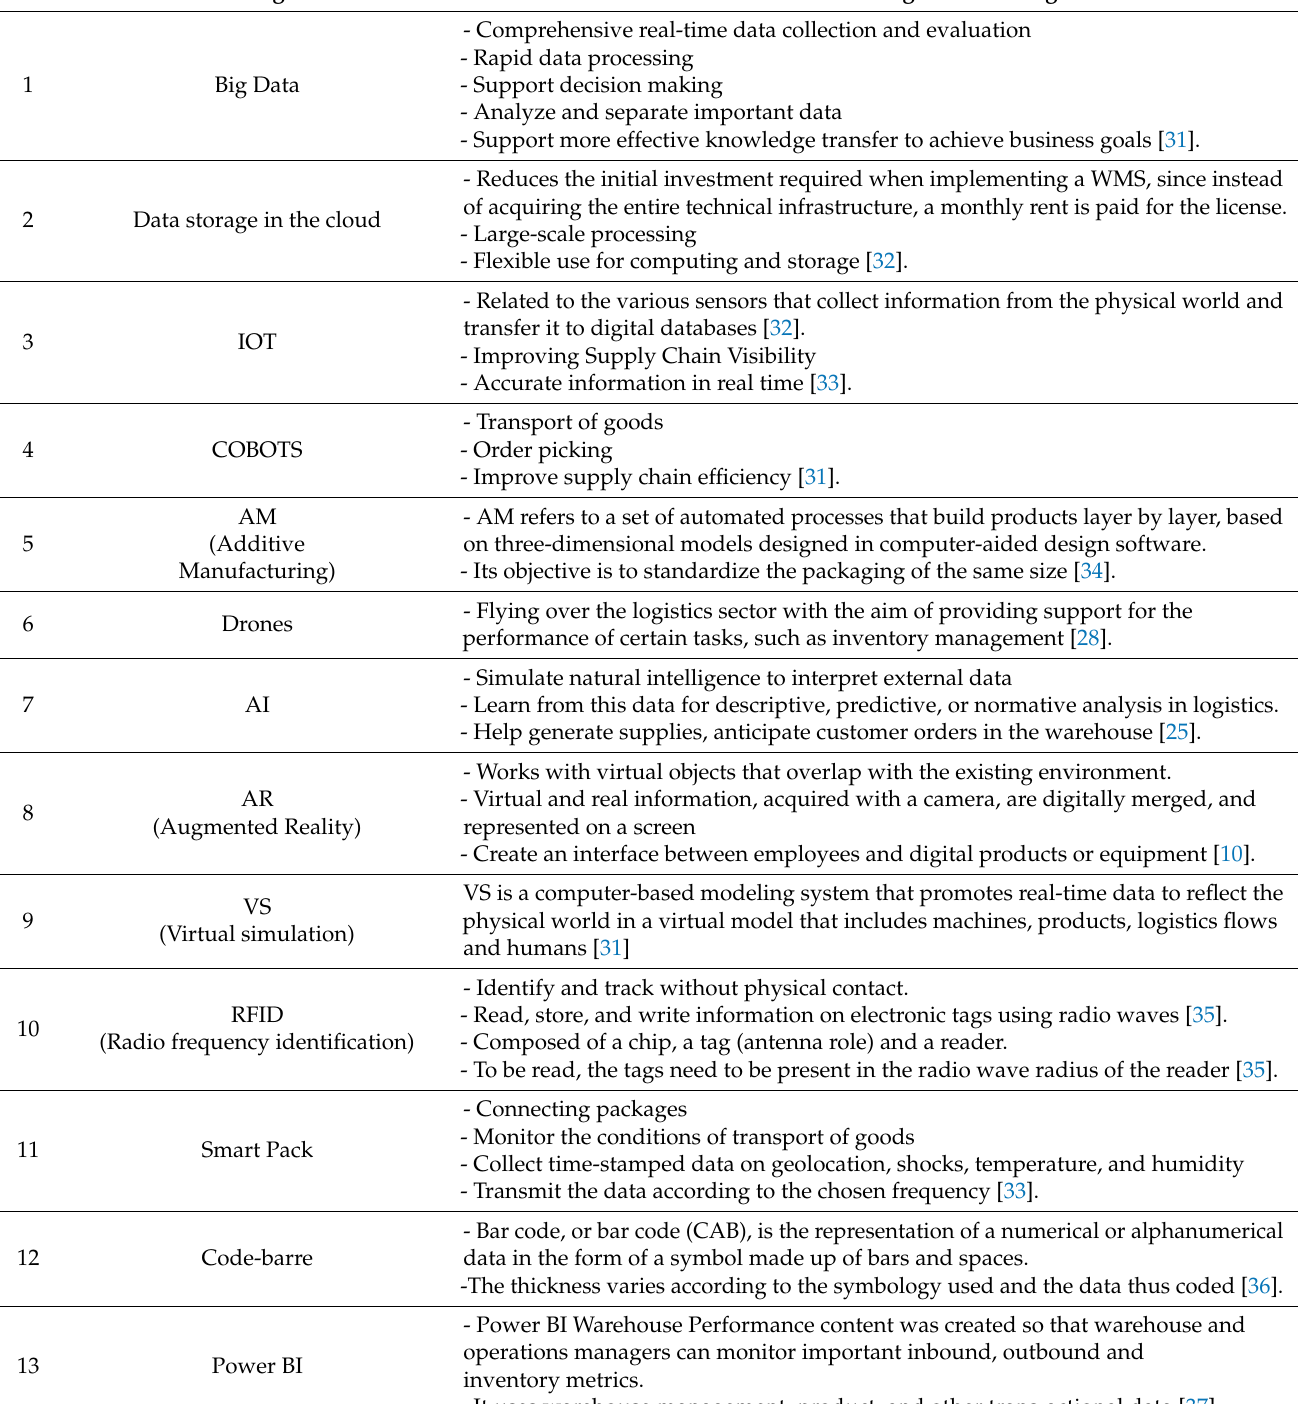
Table 2. The different 4.0 technologies used in the